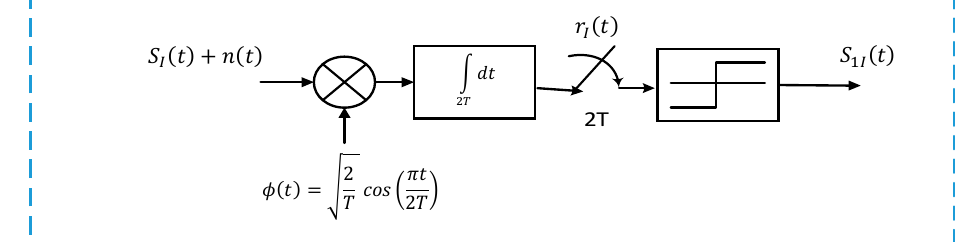
Figure 2. OSP-MSK correlator receiver.